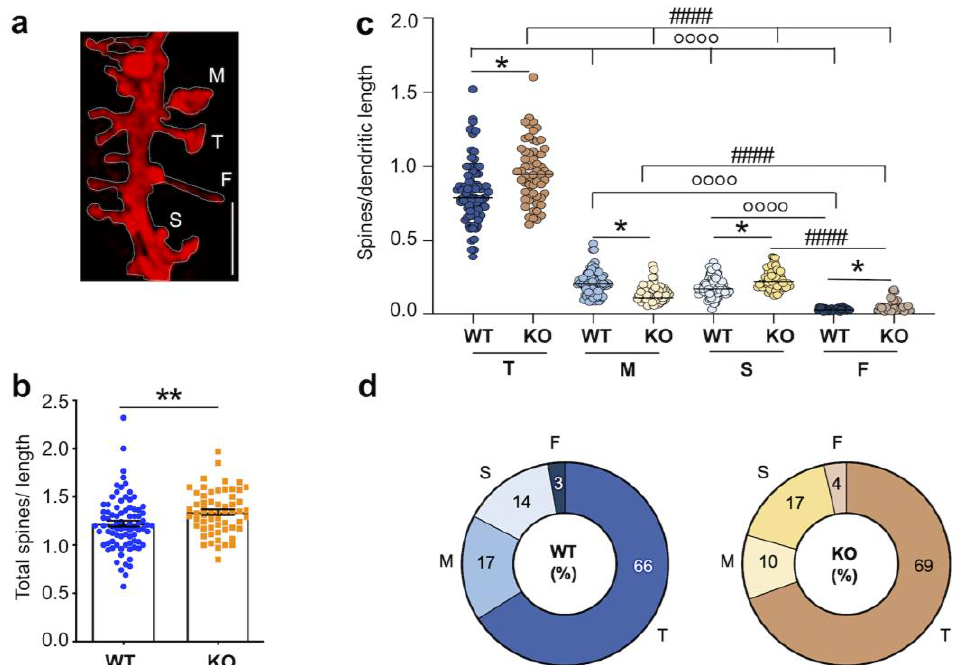
Figure 3. DiIC 18 staining reveals dysgenesis of hippocampal spines in juvenile Fmr1 KO mice. ( a ) Representative confocal image of a dendritic segment from WT mouse hippocampus, stained with DiIC 18 ; scale bar, 2 µ m. Labels indicate the different types of dendritic protrusions identified: M mushroom spines, T thin spines, S stubby spines, and F filopodia. ( b ) Quantification of total dendritic protrusions per dendritic length ( µ m) in WT and Fmr1 KO mice. Differences were evaluated by Student’s t -test; ** p = 0.006, N = 3 mice per group. ( c ) Quantification of spines density per dendritic segment and categorization by morphology as thin, mushroom, stubby spines, and filopodia. Differences were evaluated by two-way ANOVA followed by Tukey’s post-hoc multiple comparisons test * p < 0.05 KO vs. WT, ◦◦◦◦ p < 0.0001 WT vs. WT, #### p < 0.0001 KO vs. KO. The effect of genotype ( p = 0.0041) and spine’s type ( p < 0.0001) is significant. The interaction between the main